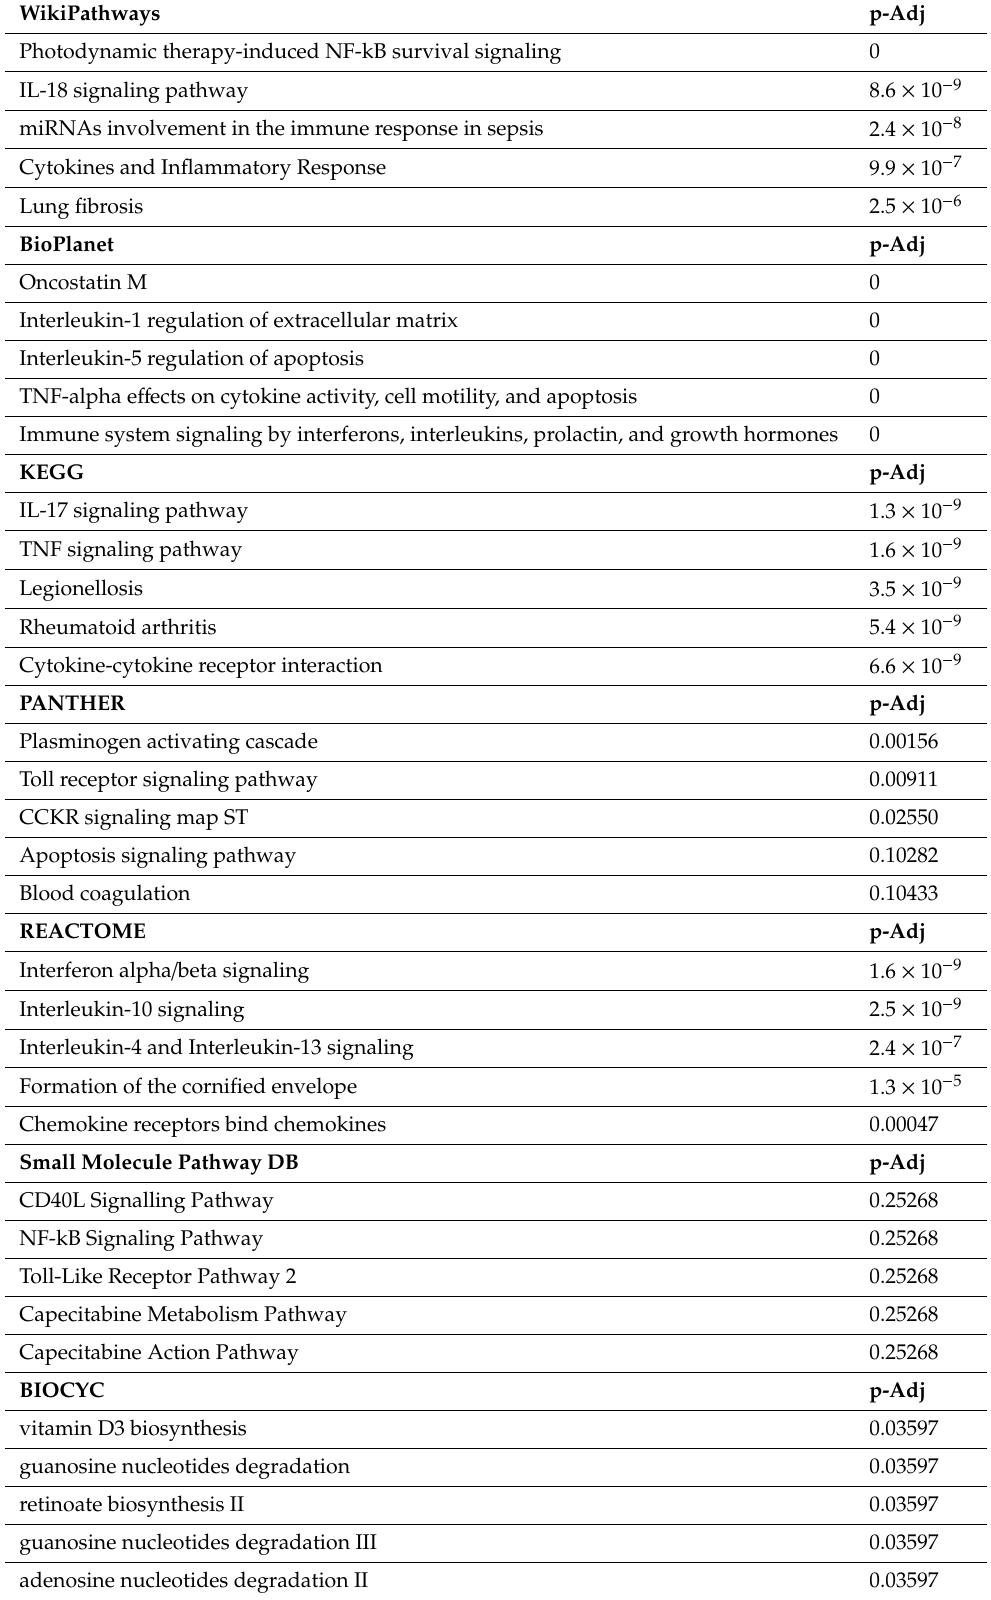
Table 4. BioProject data analysis for di ff erential gene expression between non-treated and SARS- CoV-2-treated NEHB and A549